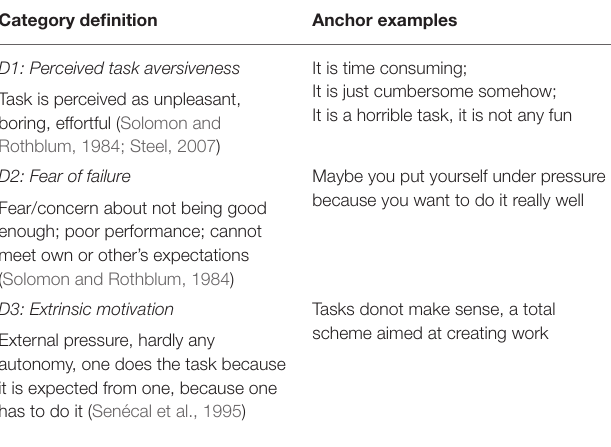
TABLE 1 | Extract of the coding guideline for reasons for teacher